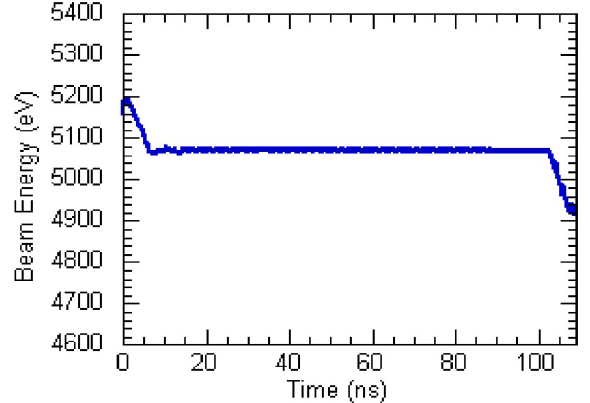
FIG. 9. (Color) Mean energy along the beam pulse for a beam with energy of 5